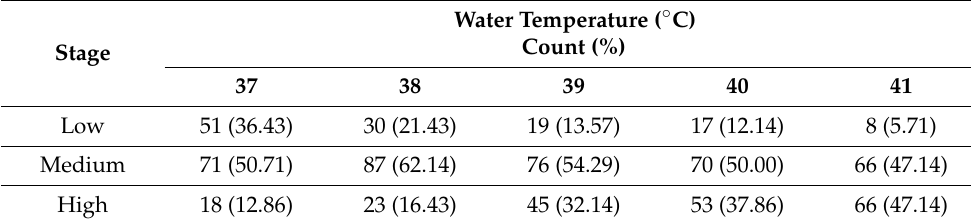
Table 5. Relationship between water temperature and the equivalent EST grouped